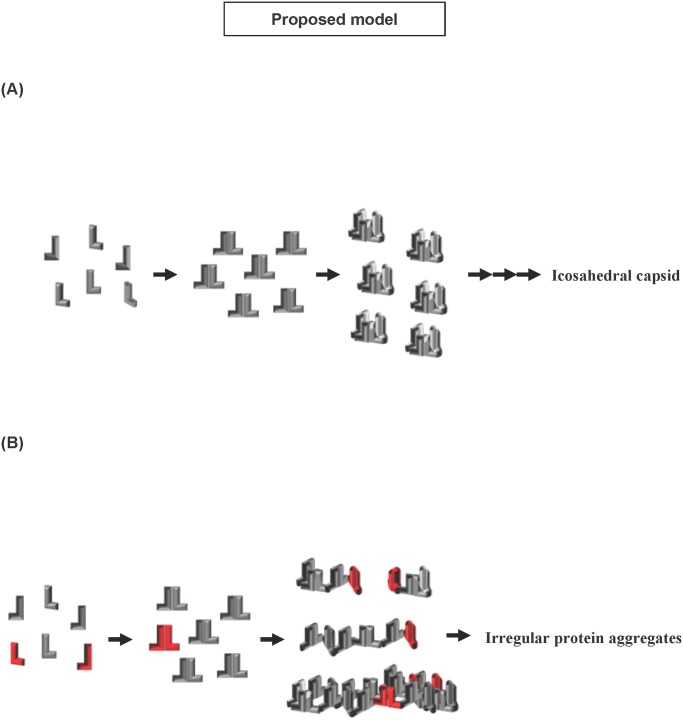
A model outlining the inhibitory effect of the p21.5 protein encoded by singly-spliced RNA on HBV replication.(A) During regular HBV nucleocapsid assembly, viral core monomers initially form core homodimers and these then further assemble into the hexamer intermediates before the quick formation of the icosahedral nucleocapsid. (B) In the presence of p21.5, p21.5 proteins initially interact with each other and form homodimers. These p21.5 homodimers and the core homodimers then form mosaic viral particles that interfere with the formation of appropriate icosahedral nucleocapsid structure. The wild-type core protein is shown in gray; the p21.5 protein, which is encoded from singly-spliced RNA, is shown in red.